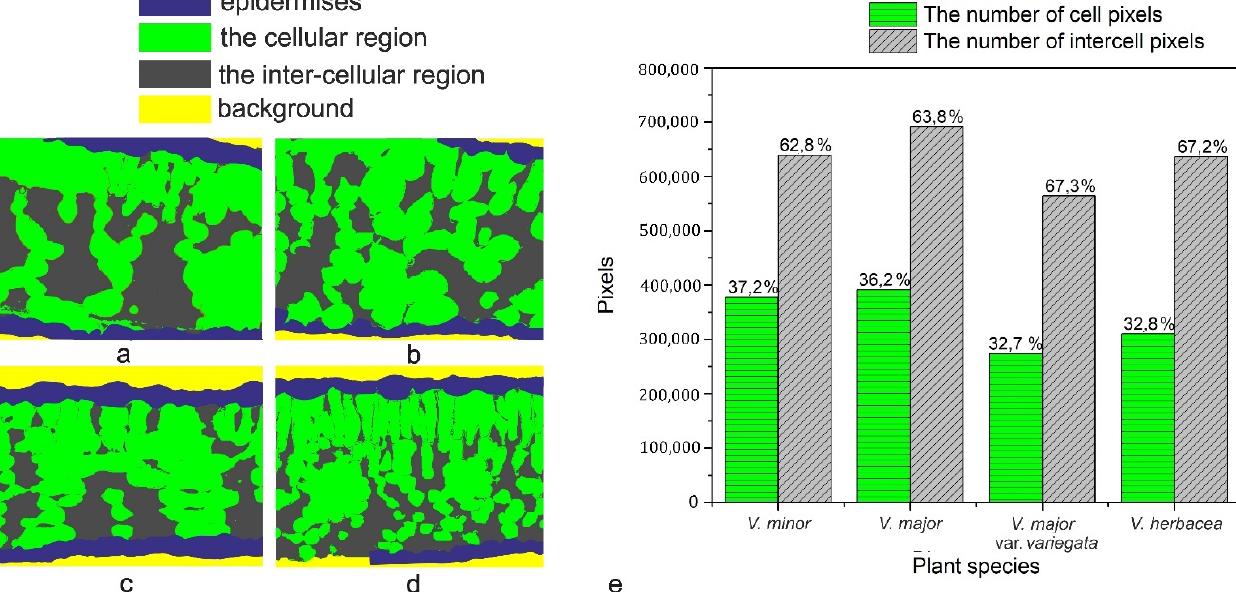
Figure 6. Computational estimation of the intercellular space of the mesophyll. ( a ) V. minor , ( b ) V. major , ( c ) V. major var. variegata , ( d ) V. herbacea , ( e ) graphical representation of the estimated number of cell pixels and inter-cell pixels as calculated using the Python script.